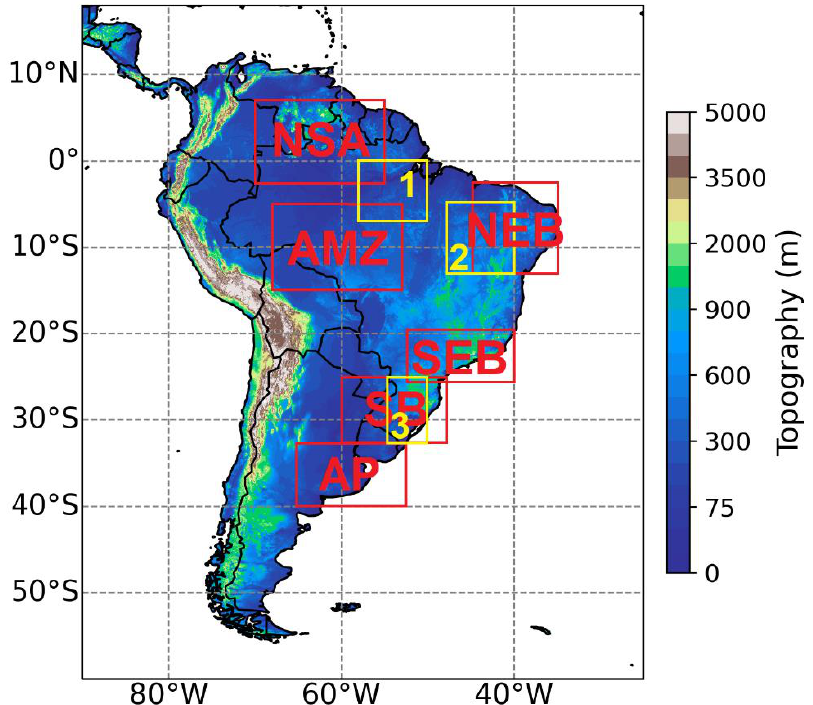
Figure 1. Selected South America subdomains for calculating regionalized trimonthly means and statistical parameters. Elevation in colors (m). Source: United States Geological Survey — Earth Resources Observation System (EROS) Center.